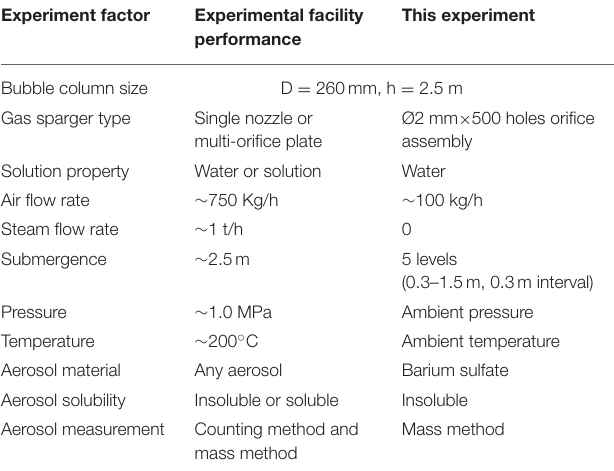
TABLE 1 | The main test facility